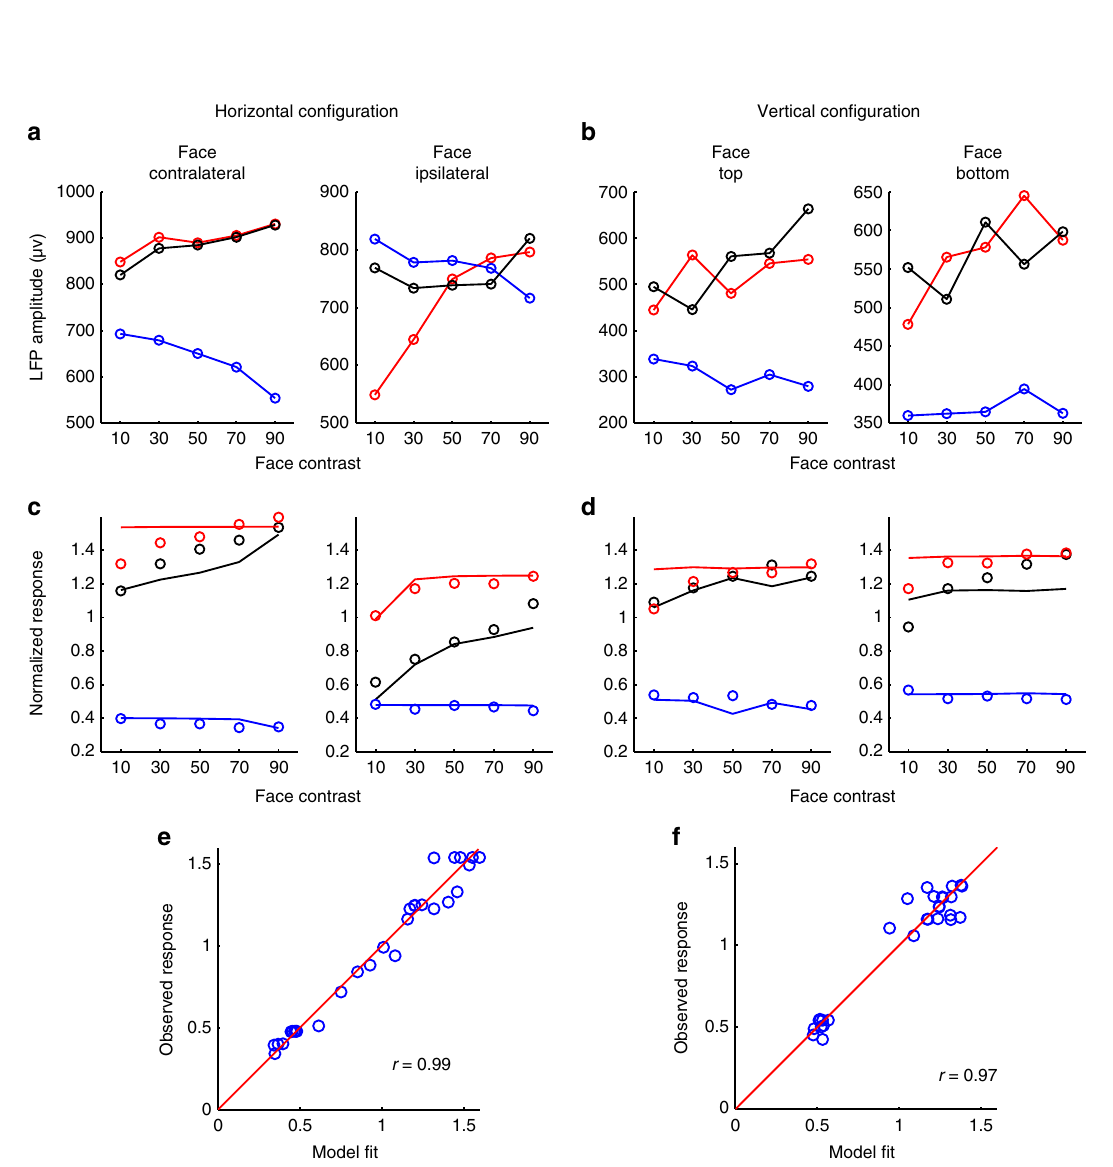
Fig. 6 The normalization model using LFP amplitudes across different contrast levels as weights predicts neural responses. a The LFP amplitudes to face- object pairs when face and object were presented horizontally. Black lines represent the LFP response to the face-object pairs at fi ve different relative contrast levels. Red (blue) lines represent the LFP response to the constituent face (object) of the corresponding face-object pair when presented in isolation. b Same as a to face-object pairs when face and object were presented vertically. c The normalization model fi t using LFP amplitudes across different contrasts as weights to the face-object experiment when faces and objects were presented horizontally (i.e., in the model, instead of using the weight multiplied by the contrast, here we used the amplitudes of the LFP across different contrasts as the weights in the model to fi t the data). Line indicates model fi t, circles indicate observed data (data same as Fig. 2b, e). d Same as c , for faces and objects presented vertically. e The correlation between the observed responses and the normalization model fi t when faces and objects were presented horizontally. We added a free LFP baseline parameter to obtain the model fi ts (i.e., the weights in the normalization model were calculated as the LFP amplitude minus the baseline). f Same as e , for face and objects presented vertically